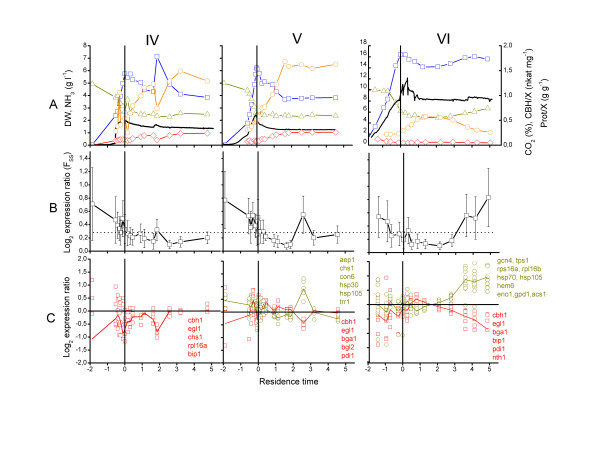
Monitoring of disturbances in gene expression stability in chemostat cultures. A. Dry weight (blue squares), off gas CO2 concentration (black line), protein concentration (g g-1 DW) (red diamonds) and cellobiohydrolase activity (nkat g-1 DW) (orange circles) and ammonium concentration (green triangles) in chemostat cultures IV–VI (D = 0.03 h-1). B. Average fold-change of expression from predicted steady state of 30 marker genes (FSS). Error bars indicate the average deviation in Fss between the different marker genes. C. Marker genes show up (green circles) or down (red squares)-regulation during the continuous phase of the cultures. Expression levels as log2 expression ratios from the Fma predicted steady state expression level